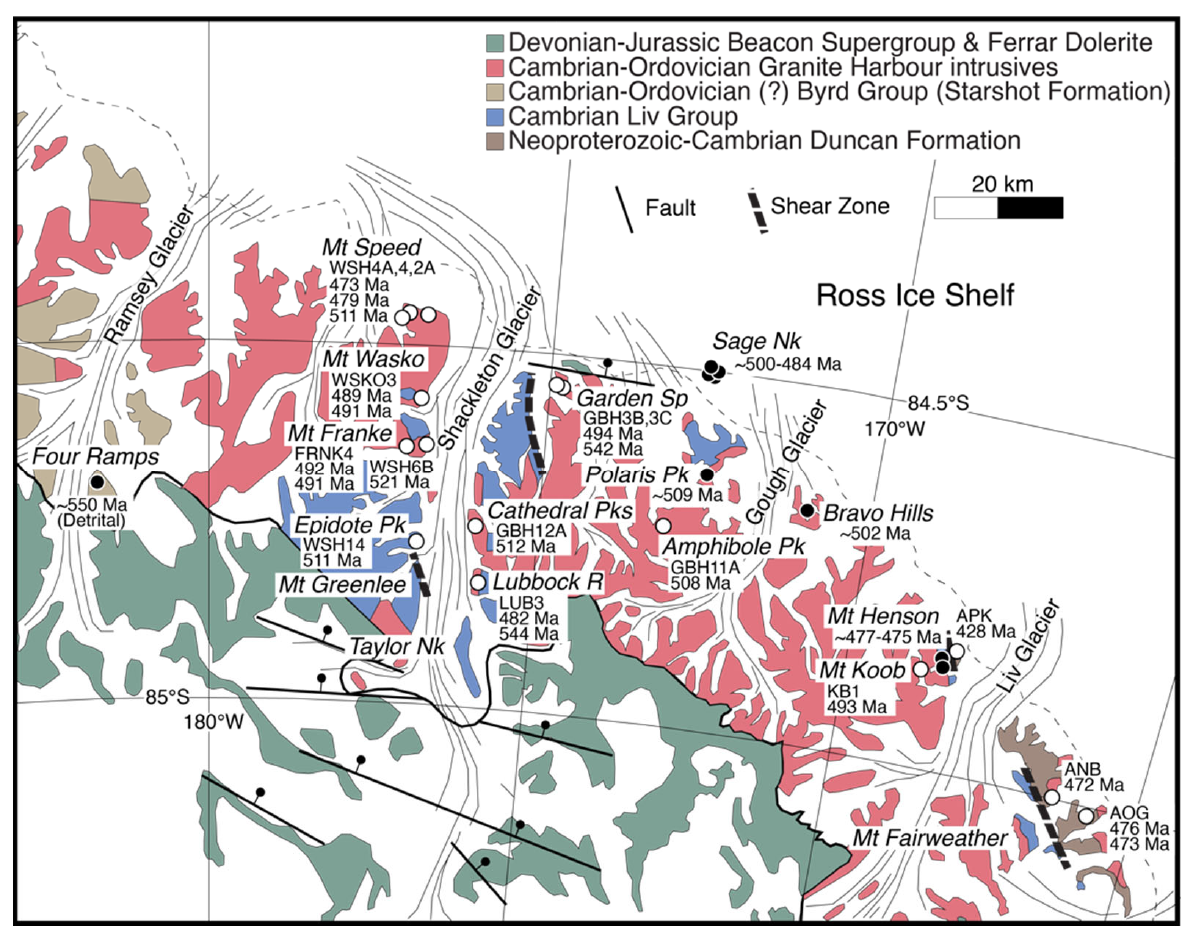
Figure 4. Simplified map showing the bedrock sample localities and geology in the Ramsey, Shack- leton, and Liv Glacier areas (modified from [18]. White circles show localities of metasedimentary and intrusive rock samples analyzed herein using 40 Ar/ 39 Ar method. Black circles show locations of previous 40 Ar/ 39 Ar analyses of intrusive rocks and sedimentary rocks reported in [45,48,51,54]. The Cambria–Ordovician Starshot Formation in the Ramsey Glacier area was originally mapped as Goldie Formation but shown as Starshot Formation after [37].